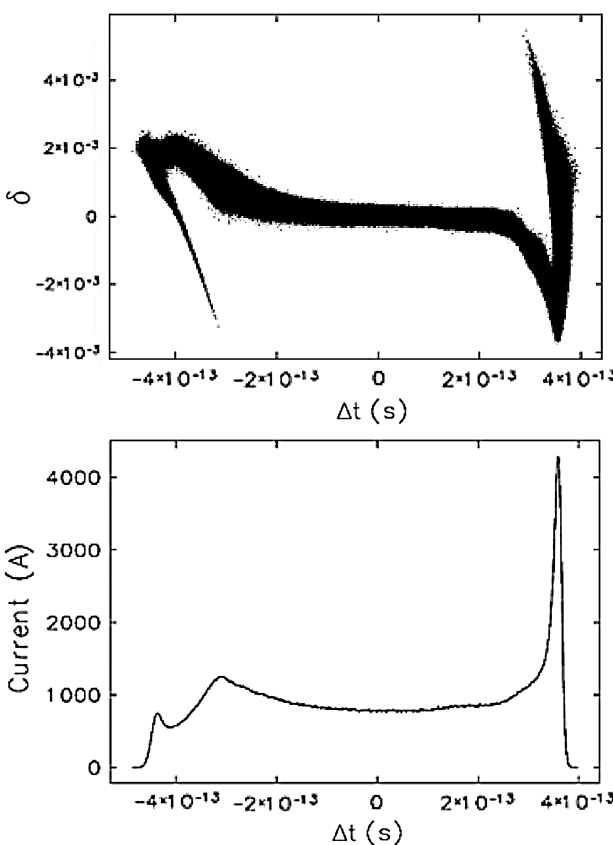
FIG. 2. Longitudinal phase space (top) and current profile (bottom) of the FERMI@elettra electron beam at the linac end after the single compression in BC1 by a factor 10. The bunch head is for negative time